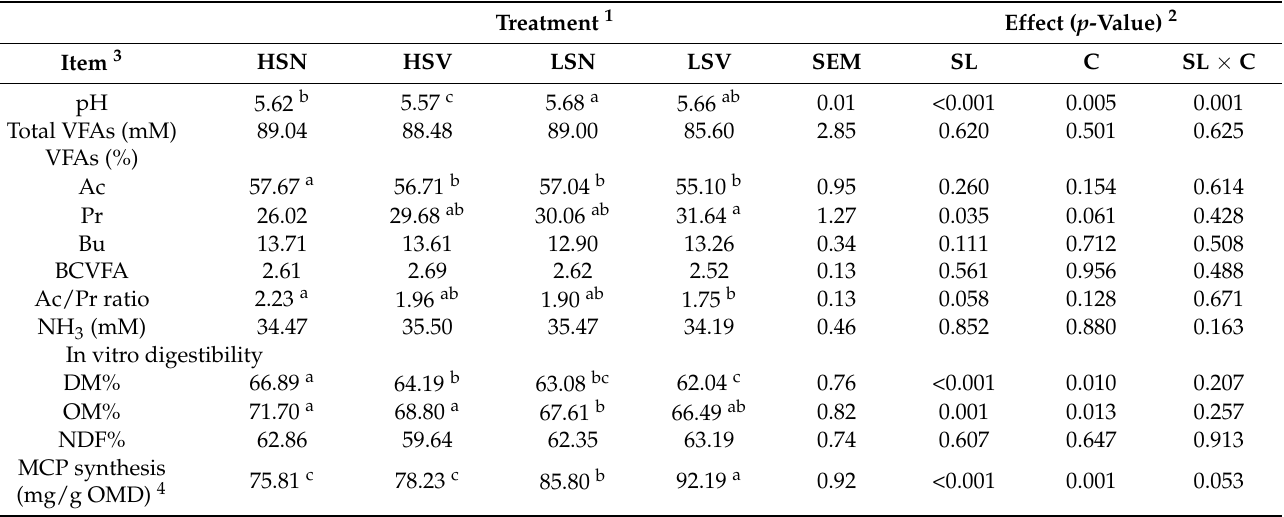
Table 5. The effect of M-CMS supplementation with different corn silage levels on fermentation parameters and in vitro digestibility (Experiment